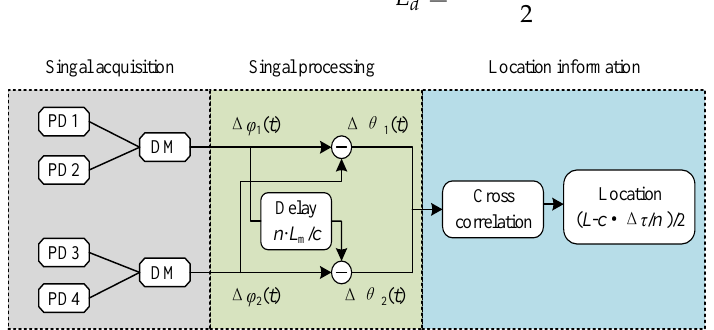
Figure 2. Block diagram of the delay estimation algorithm.